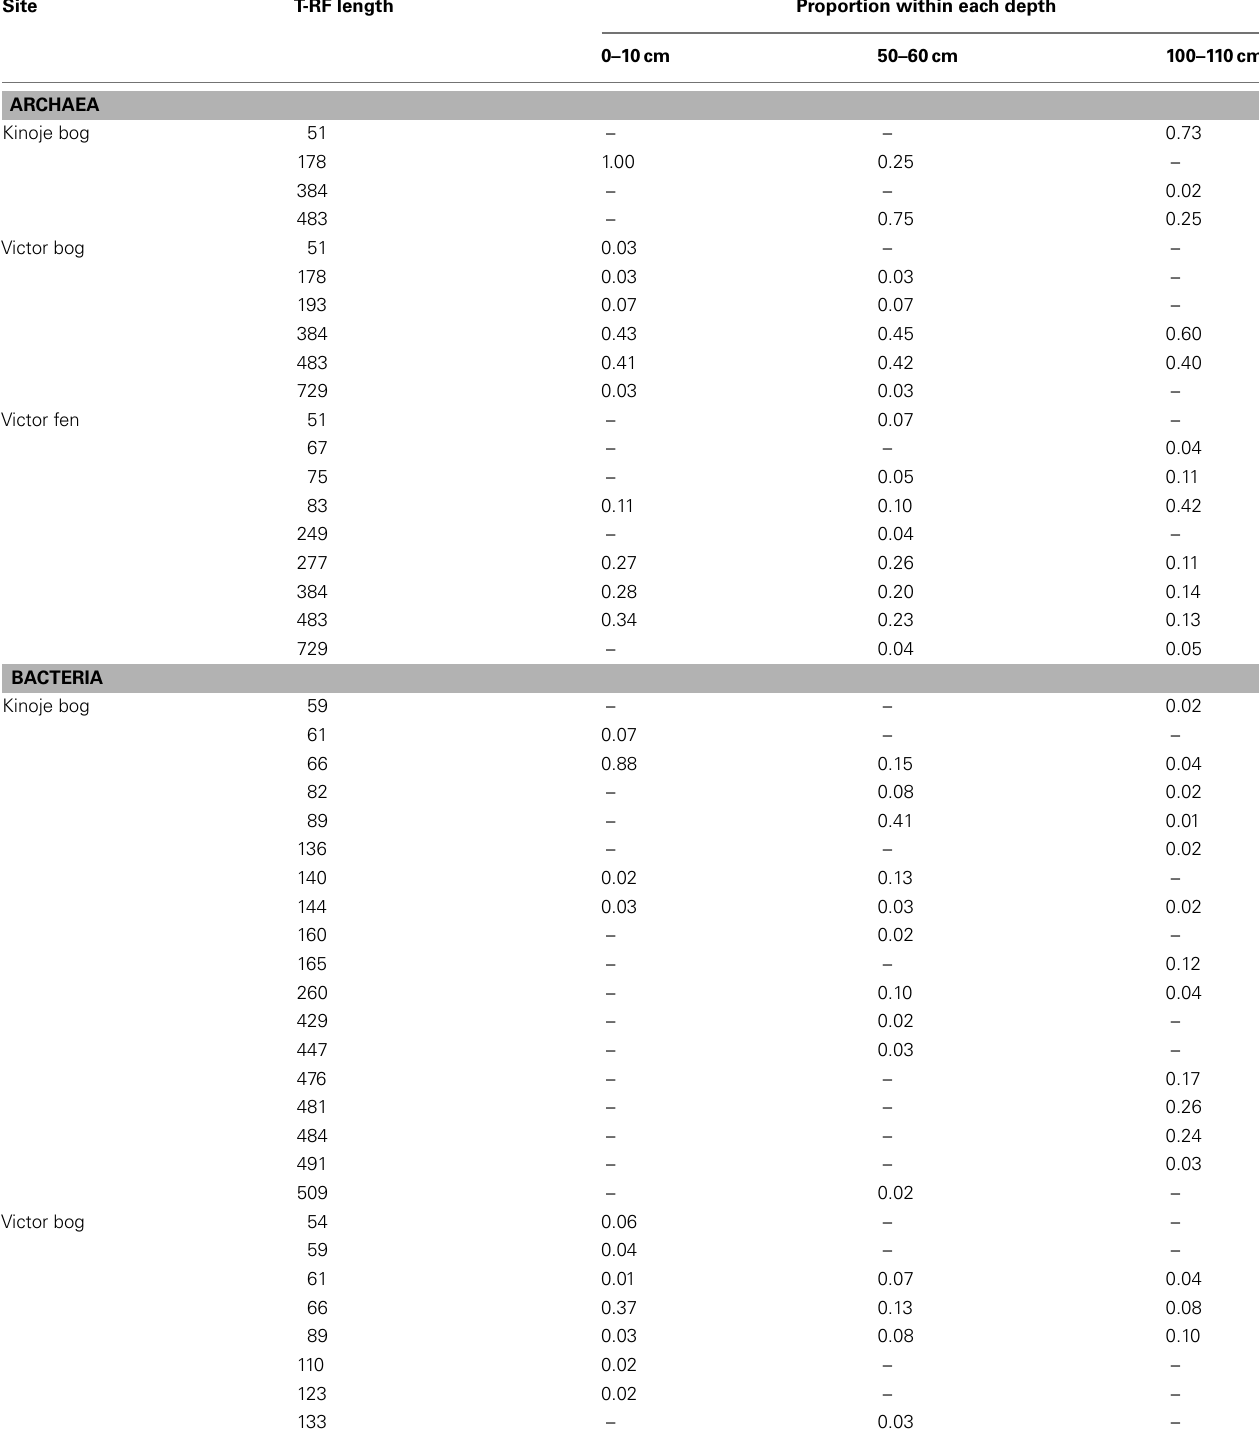
TableA1 | Operational taxonomic units (OTU) of archaea, bacteria, and fungi identified at three depths in peatlands across the James Bay Lowlands, Canada using terminal restriction fragment length polymorphism analysis (T-RFLP) of